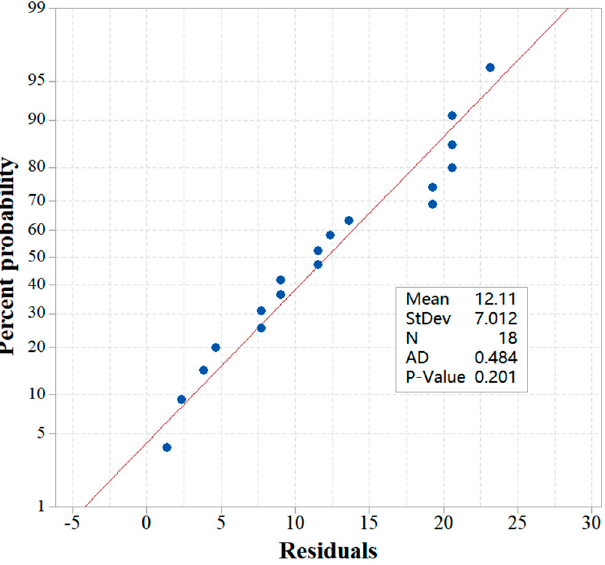
Figure 3. The results of the Anderson–Darling normality test.